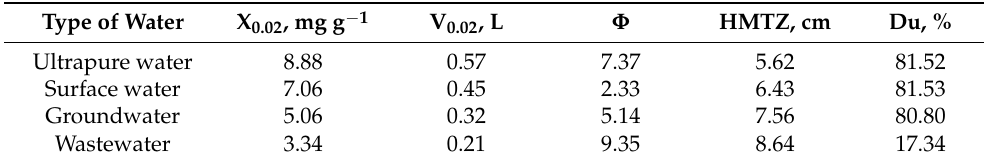
Table 7. Results derived from the Cu (II) breakthrough curves in natural waters in waste sludge columns.